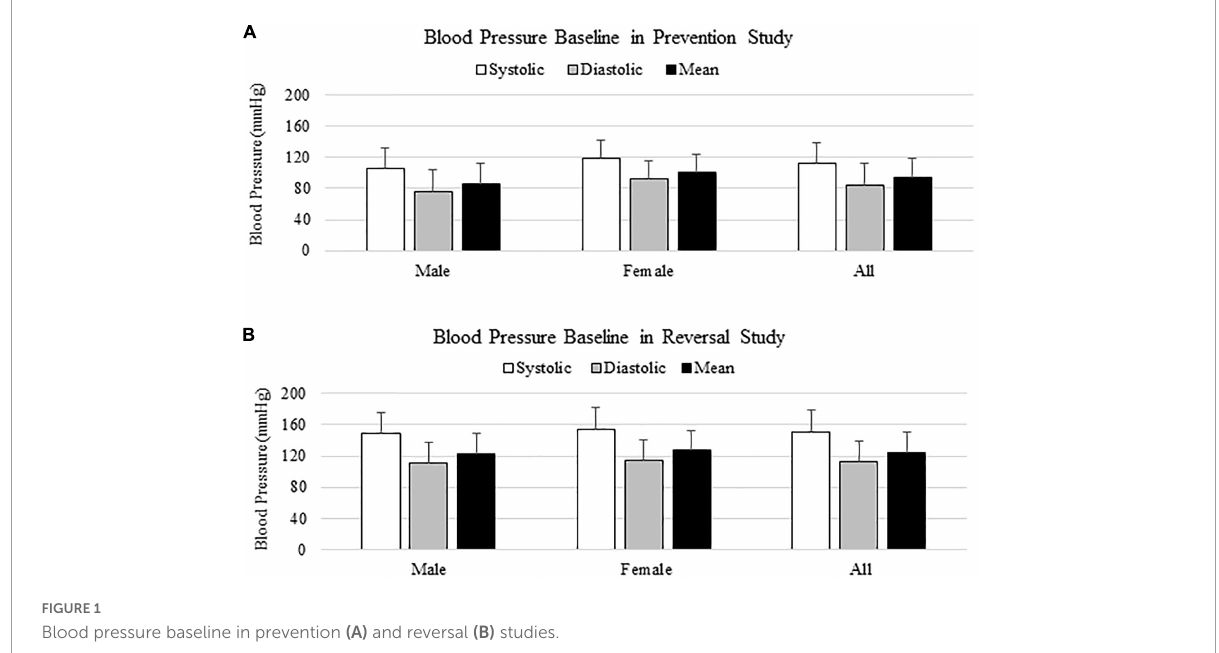
FIGURE1 Blood pressure baseline in prevention (A) and reversal (B) studies.